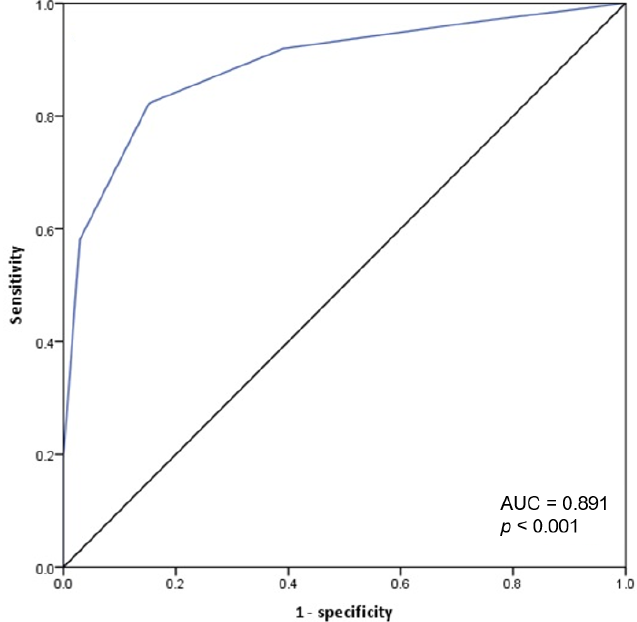
Figure 2. Receiver operating characteristics (ROC) curve for the predictive score of SFTS group. Prediction score system = (1 × poor oral intake) + (1 × lymphadenopathy) + (1 × ambient temperature ≥ 20 °C) + (1 × ANC ≤ 2000 cells/μL) + (1 × CRP ≤ 1.2 mg/dL) + (1 × CK ≥ 200 IU/L).